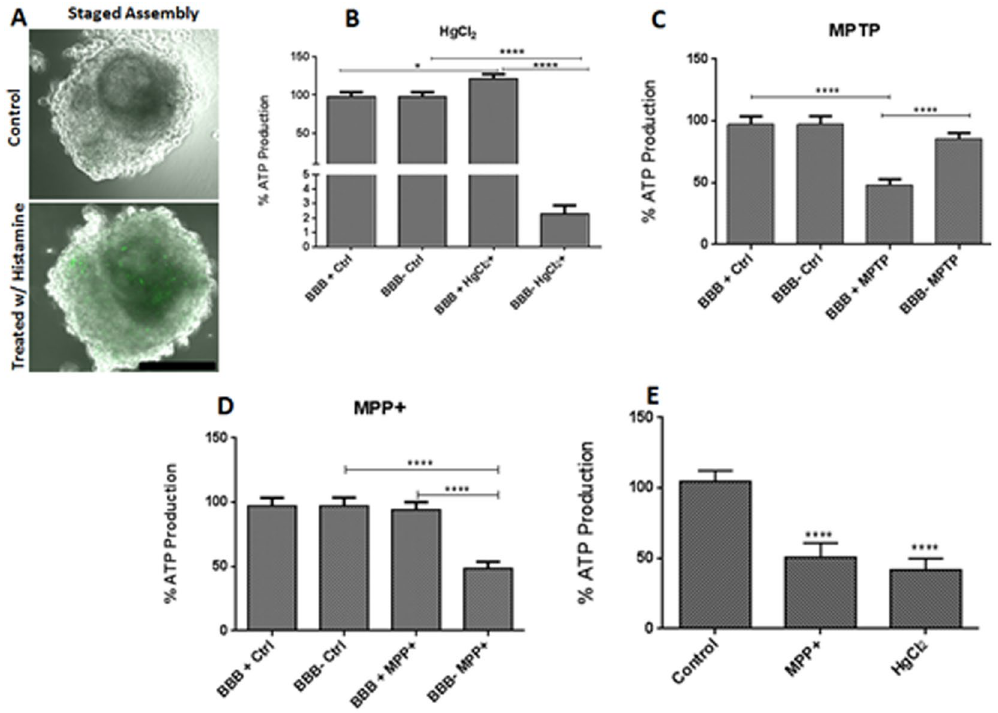
Figure 4. BBB Integrity and selectivity using FITC labeled IgG, Mercury, MPTP and MPP + . ( A ) Shows IgG permeability in untreated (upper panel) and Histamine treated (lower panel) spheroids. ( B – D ) Results from 4 separate experiments were pooled and normalized to the ATP production in untreated spheroids. Neuronal (BBB − ) spheroids treated with mercury (II) chloride ( B ) exhibited low ATP production. Spheroids consisting of all six cell types (BBB + ) that were treated with mercury (II) chloride exhibited higher viability and were statistically significant with respect to their untreated counterparts. In C , there was no significant in ATP production in untreated versus MPTP treated BBB − spheroids. MPTP treated BBB + spheroids exhibited significantly low ATP production compared to the untreated group. MPP + ( D ) BBB − spheroids exhibited significantly lower ATP production compared to the untreated neuronal spheroids. BBB + spheroids that were treated with MPP + exhibited no significantly different cell viability compared to the untreated group. In E , BBB + spheroids were treated with Histamine to allow MPP + and Mercury ion to penetrate into the organoids. Both MPP + and mercury (II) chloride demonstrated significantly lower ATP production compared to untreated control. Student T-Test, two tailed hypothesis, * P < 0.05, **** P < 0.0001, with untreated spheroids, n organoids = 64 ( B – D ), n organoids = 32 ( E , experiment only perfomed once). Data represented as mean ±